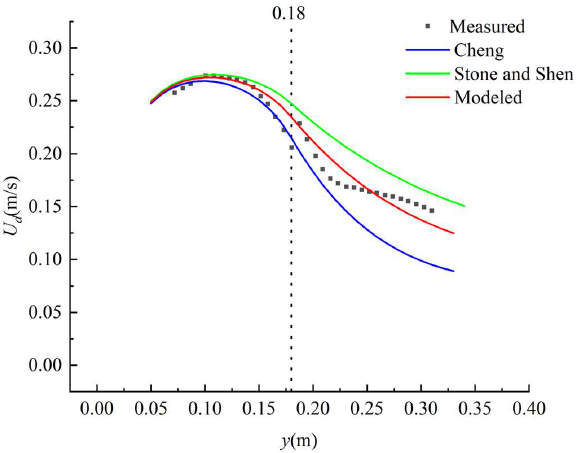
Figure 3. The water depth-averaged streamwise velocity between the experimental data and ana- lytical solution in case 2. φ 1 = 0.6522, φ 2 = 0.662, and φ 3 = 0.4681.